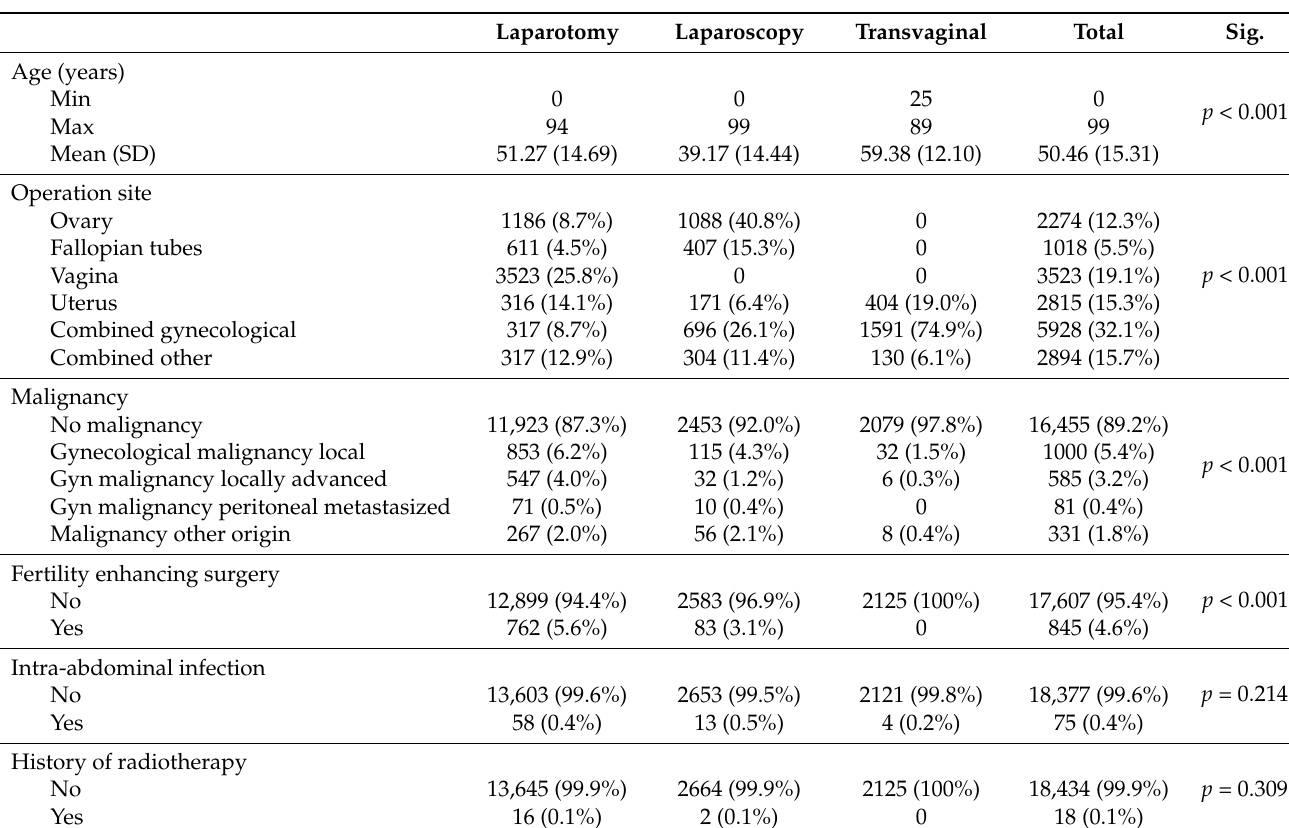
Table 2. Baseline